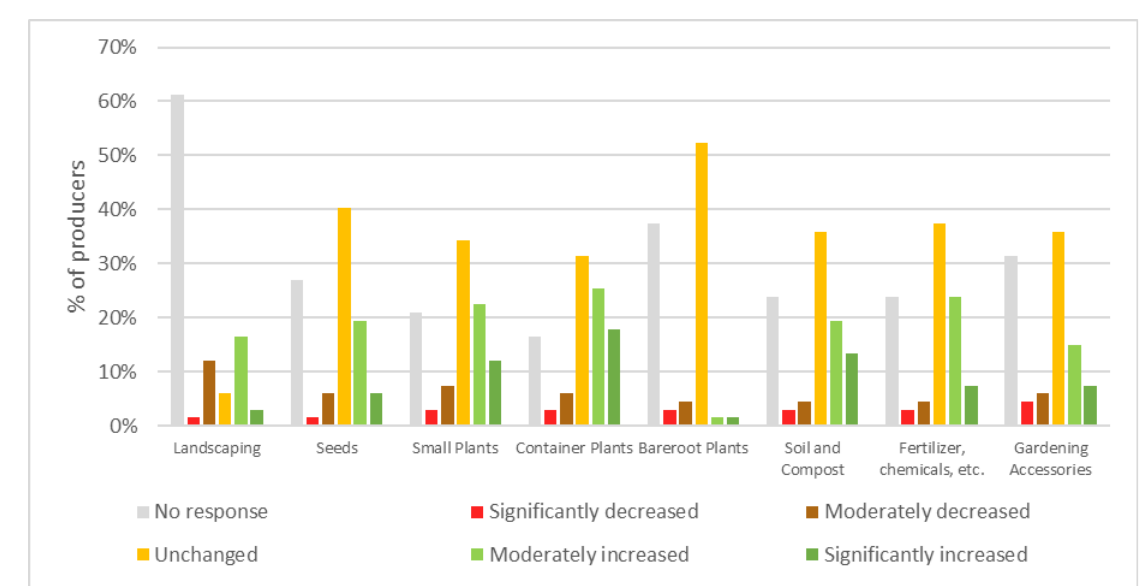
Figure 2. Percentage of producers who indicated change in purchasing of gardening products/services during the pandemic, based on producer surveys.